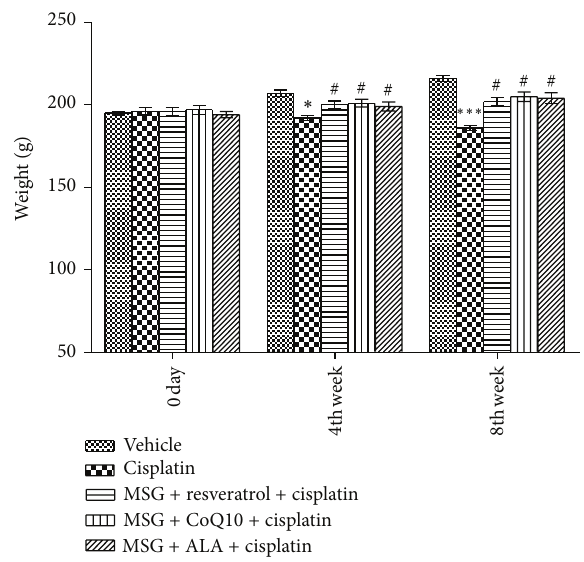
Figure 2: Effect of chronic treatment with combination of MSG and resveratrol/ALA/Co Q10 on body weight. ∗ ( 𝑃 < 0.05 ), ∗∗∗ ( 𝑃 < 0.001 ) versus control group, # ( 𝑃 < 0.05 ) versus cisplatin treated group.